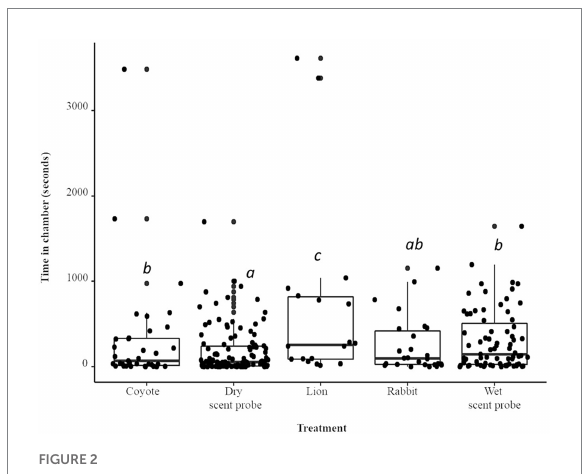
FIGURE 2 Boxplot and jittered scatterplot of visits to the chamber by two species of wild rodent, striped ( A. agrarius ) and yellow-necked ( A. flavicollis ) mice. Pairwise comparisons in superscript are significant at the level of p < 0.005.